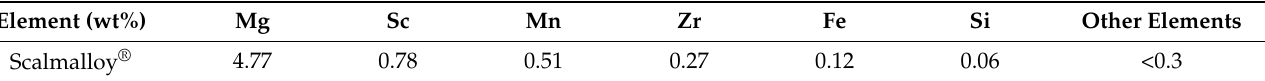
Table 1. Scalmalloy ® chemical composition.